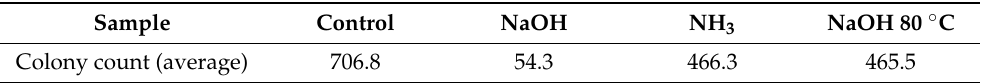
Figure 3. Antibacterial activity of ( a ) control, ( b ) NaOH sample ( c ) NH 3 sample, and ( d ) 80 °C treated NaOH sample.